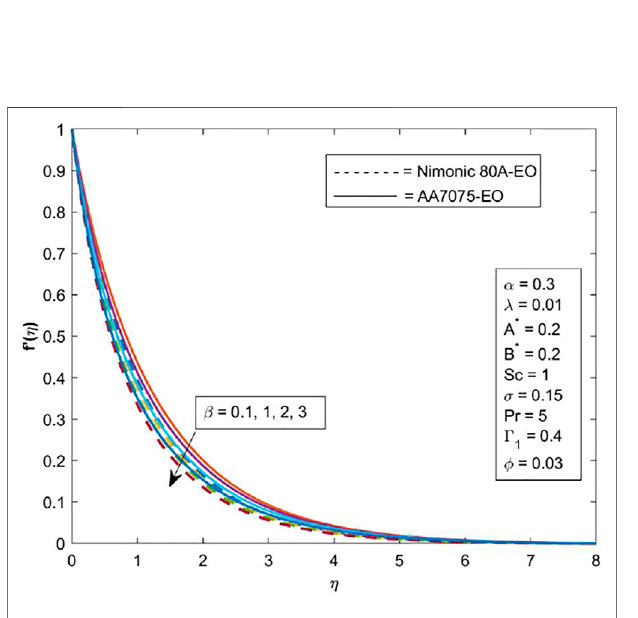
FIGURE 1 | Provocation of β on f ′ .